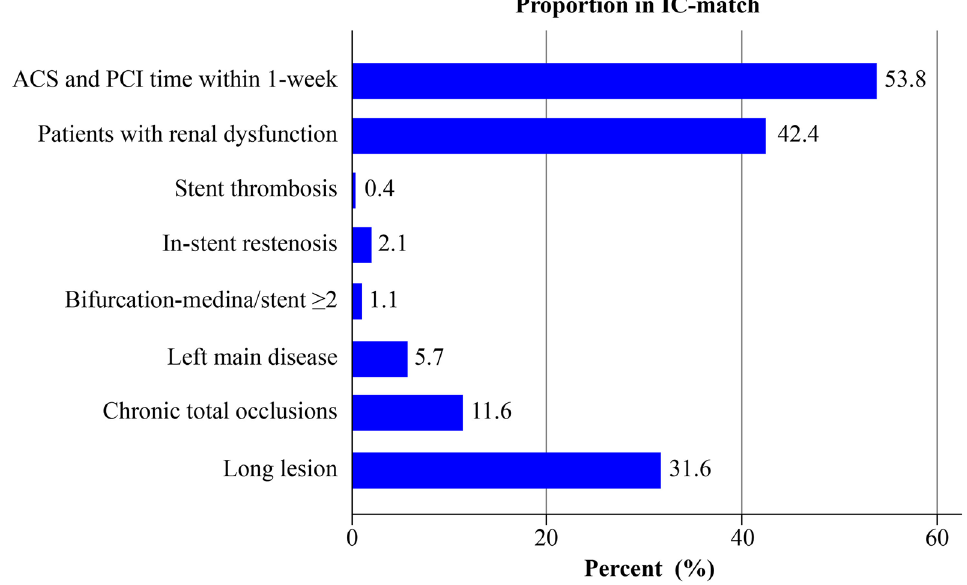
Figure 2. Distribution of the adjunctive use criteria for intravascular ultrasound among the patients who have met the criteria (C + group, n = 15,966). Abbreviations: ACS, acute coronary syndrome; IC, intravascular ultrasound adjunctive use criteria; PCI, percutaneous coronary intervention. Bifurcation lesions that were included in the C + group were true bifurcation lesion with Medina classification 1,1,1/ 0,1,1/ 1,0,1 and number of stent use of 2 or more.